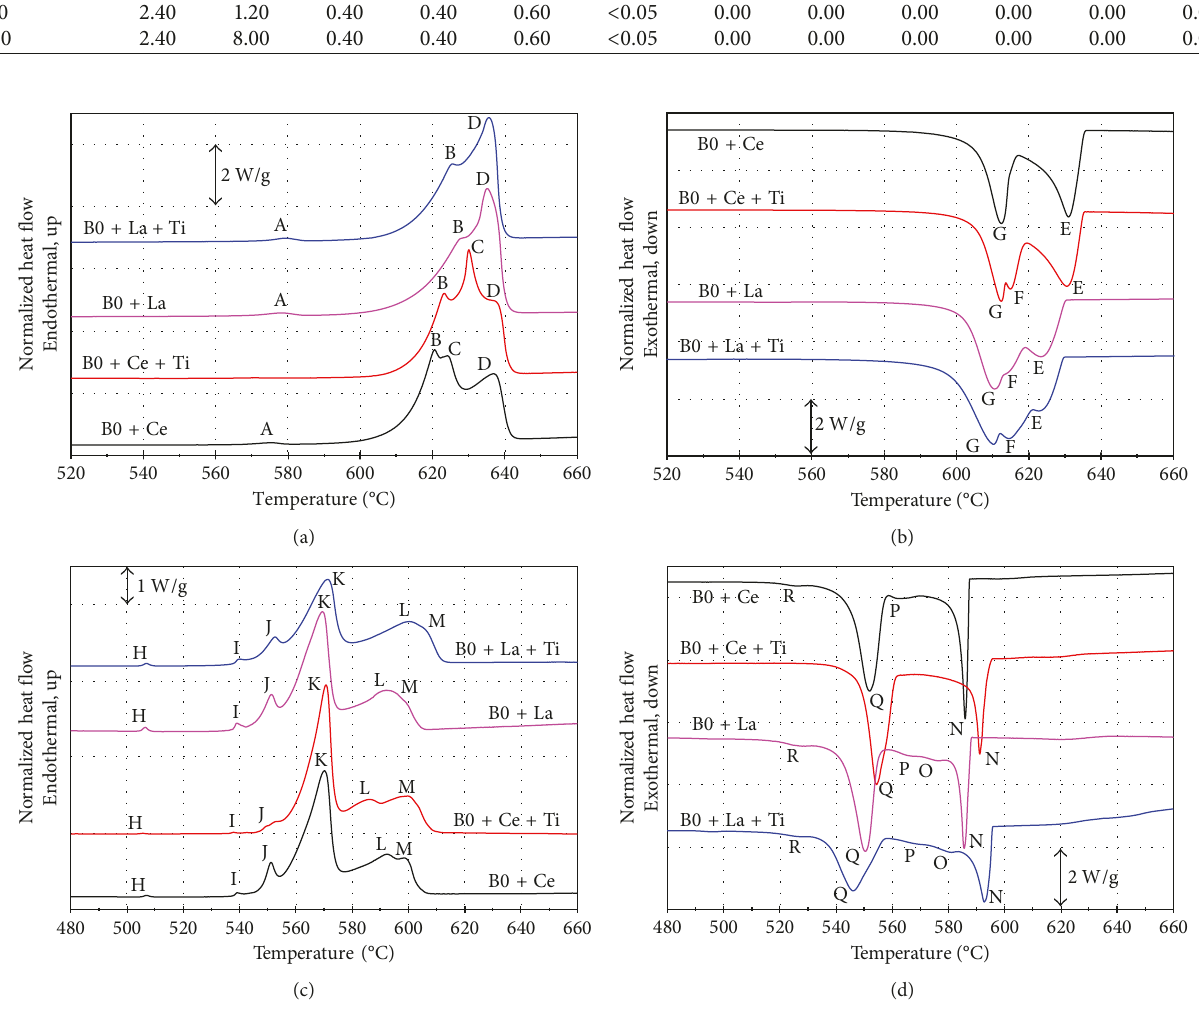
Figure 1: DSC heating and cooling curves of B0-based (a and b) and D0-based (c and d)